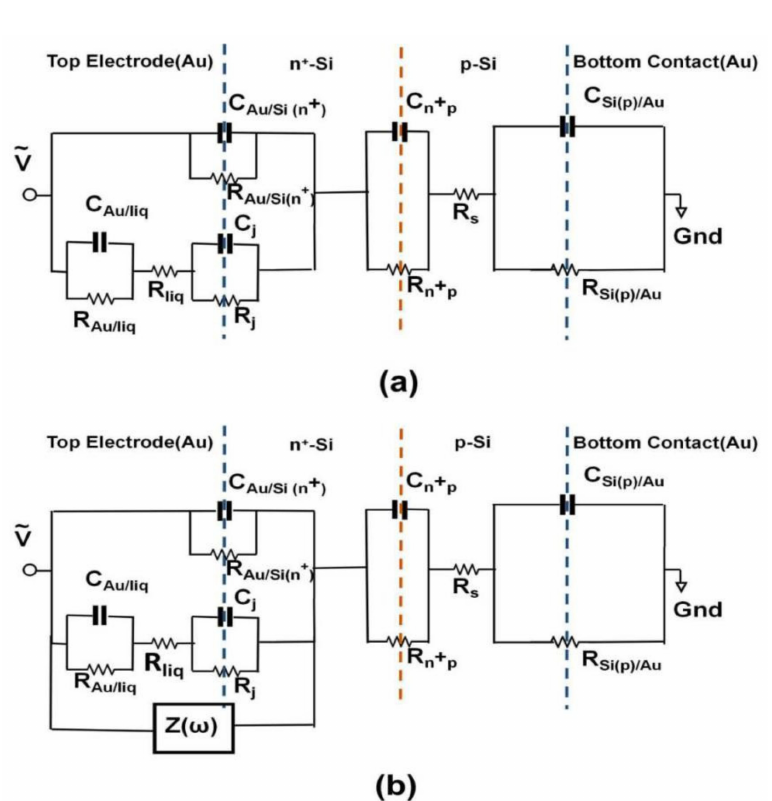
Figure 6. Equivalent circuit model of PS5 for ( a ) No Fill and 20 µ L Dl. The changes in impedance (Figure 4) after addition of 1 µ L, 2 µ L, 3 µ L, 4 µ L, and 5 µ L into the region of the ring top electrode are extracted by adding ( b ) Z( ω ) in parallel to the ring electrode impedance components of 20 µ L DI ( a ). Modeled values of RC pairs are listed in Table A1. The left blue, orange, and right blue dotted line indicates the interface between Au ring electrode and Si(n+), the position of n + p junction and the interface between Si(p) and Au bottom electrode,